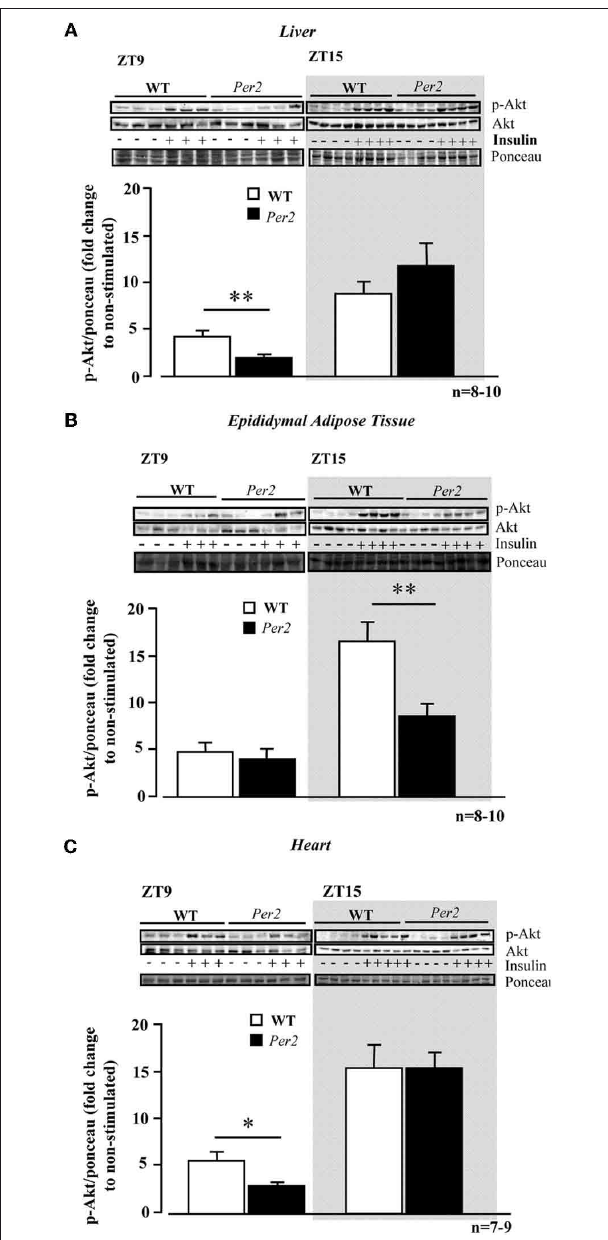
FIGURE 2 | Compromised Akt activation in response to insulin in the liver (A), epididymal adipose tissue (B), and heart (C) of mPer2 Brdm1 mice. Representative immunoblotting and respective quantifications of Akt-S473 phosphorylation upon intraperitoneal injection of insulin (0.5mU/g body weight, 5min) at ZT9 and ZT15 ( n = 7 − 10), respectively. The symbol “ − ” or “ + ” means without or with insulin stimulation, respectively. ∗ p < 0 . 05 and ∗∗ p < 0 . 01 between the indicated